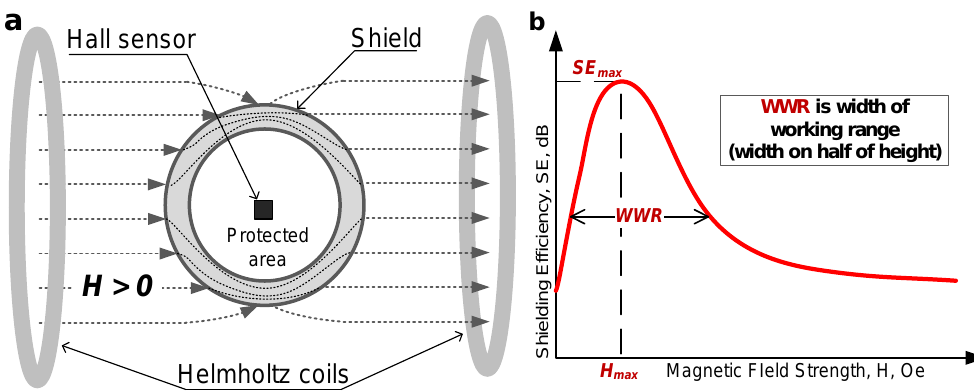
Figure 2. Schematic representation of the shielding efficiency measurement: ( a ) installation for shielding efficiency (SE) measurement of the cylindrical shields and ( b ) schematic representation of graph of the change in SE.